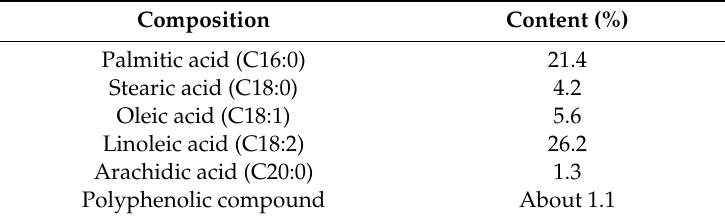
Table 2. Composition and content of fatty acid, content of polyphenolic compound in the co ff ee oil.